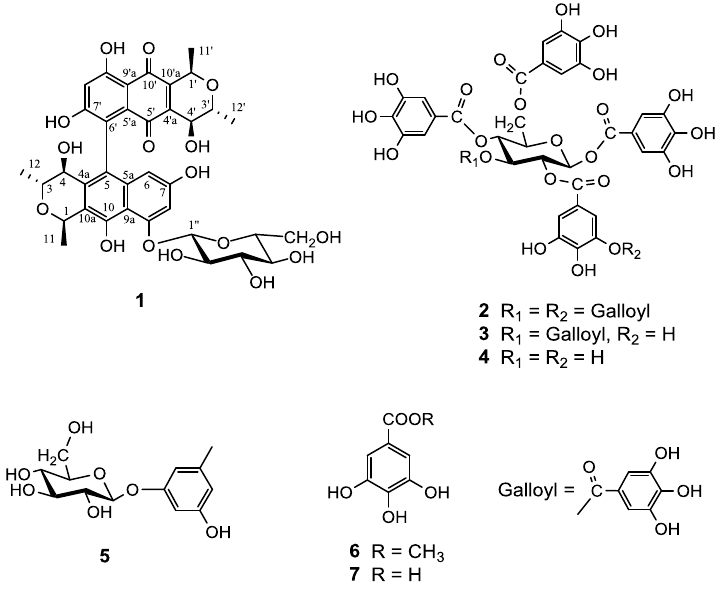
Figure 1. Structures of isolated compounds 1 – 7 from Galla